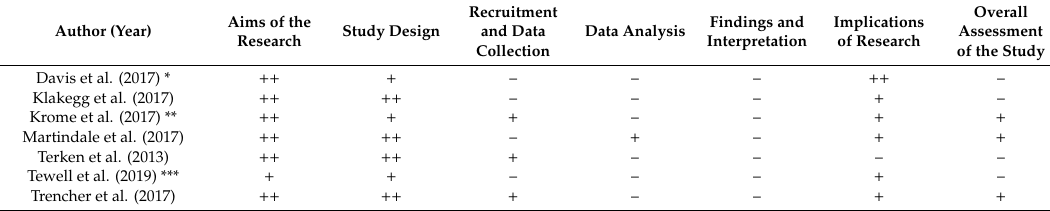
Table 2. Quality assessment of qualitative articles included in the systematic review ( n =